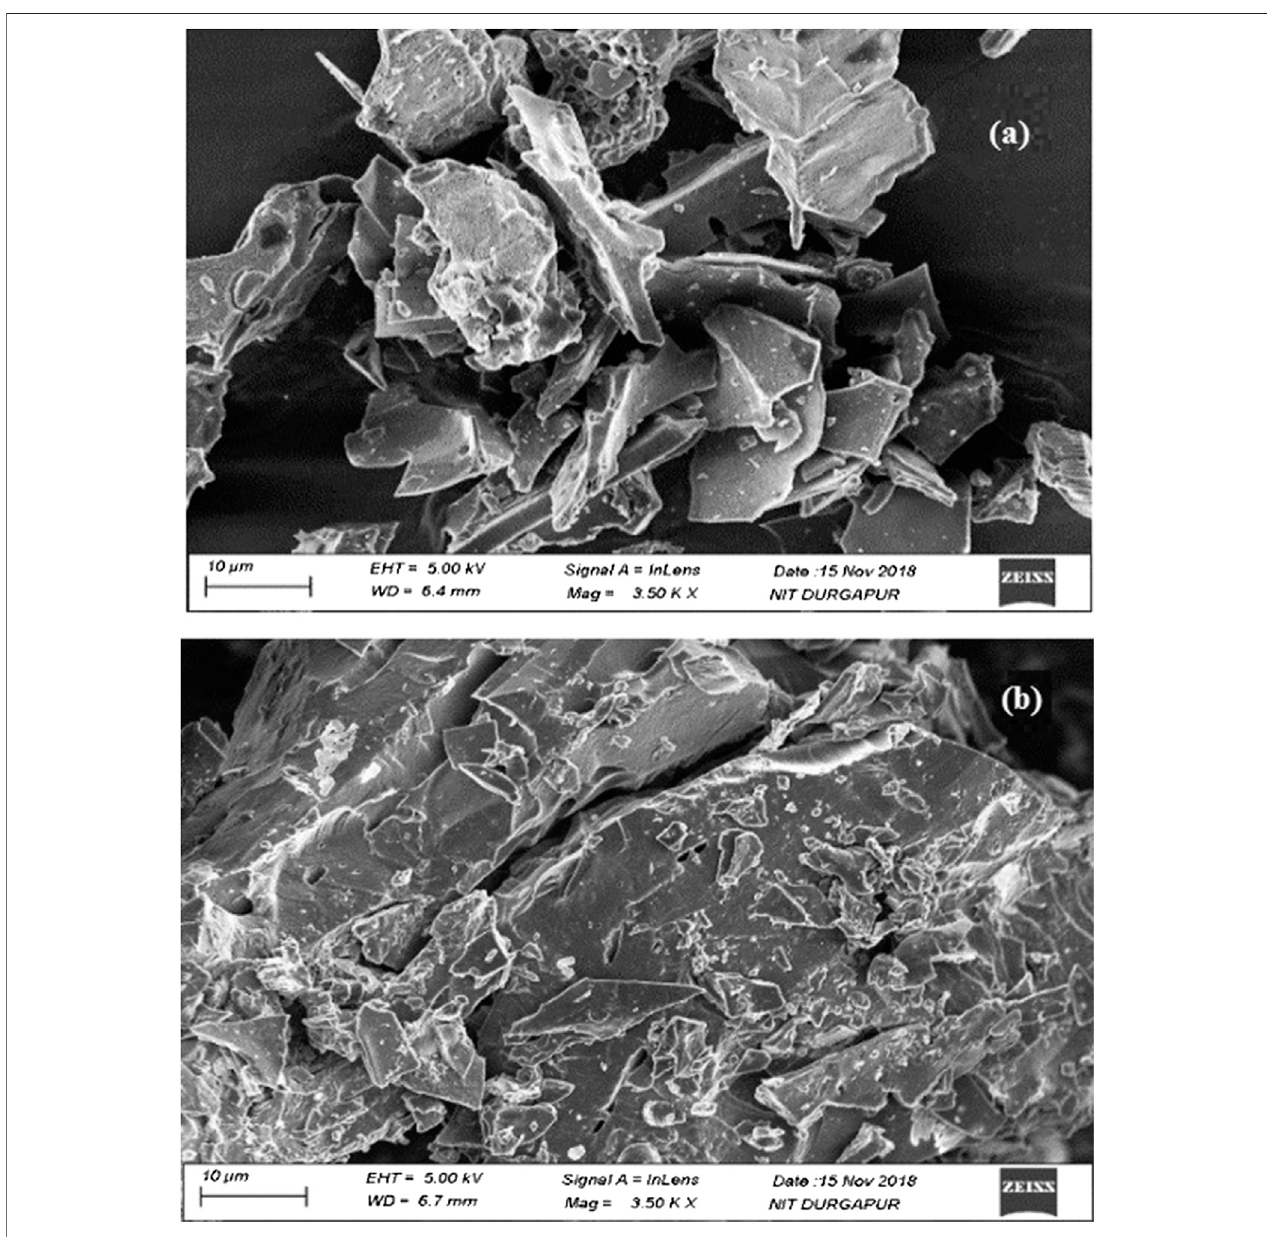
FIGURE 2 | SEM image of Mesua ferrea linn (MFL) (A) activated carbon (AC) and (B) sulfonated carbon (SC).